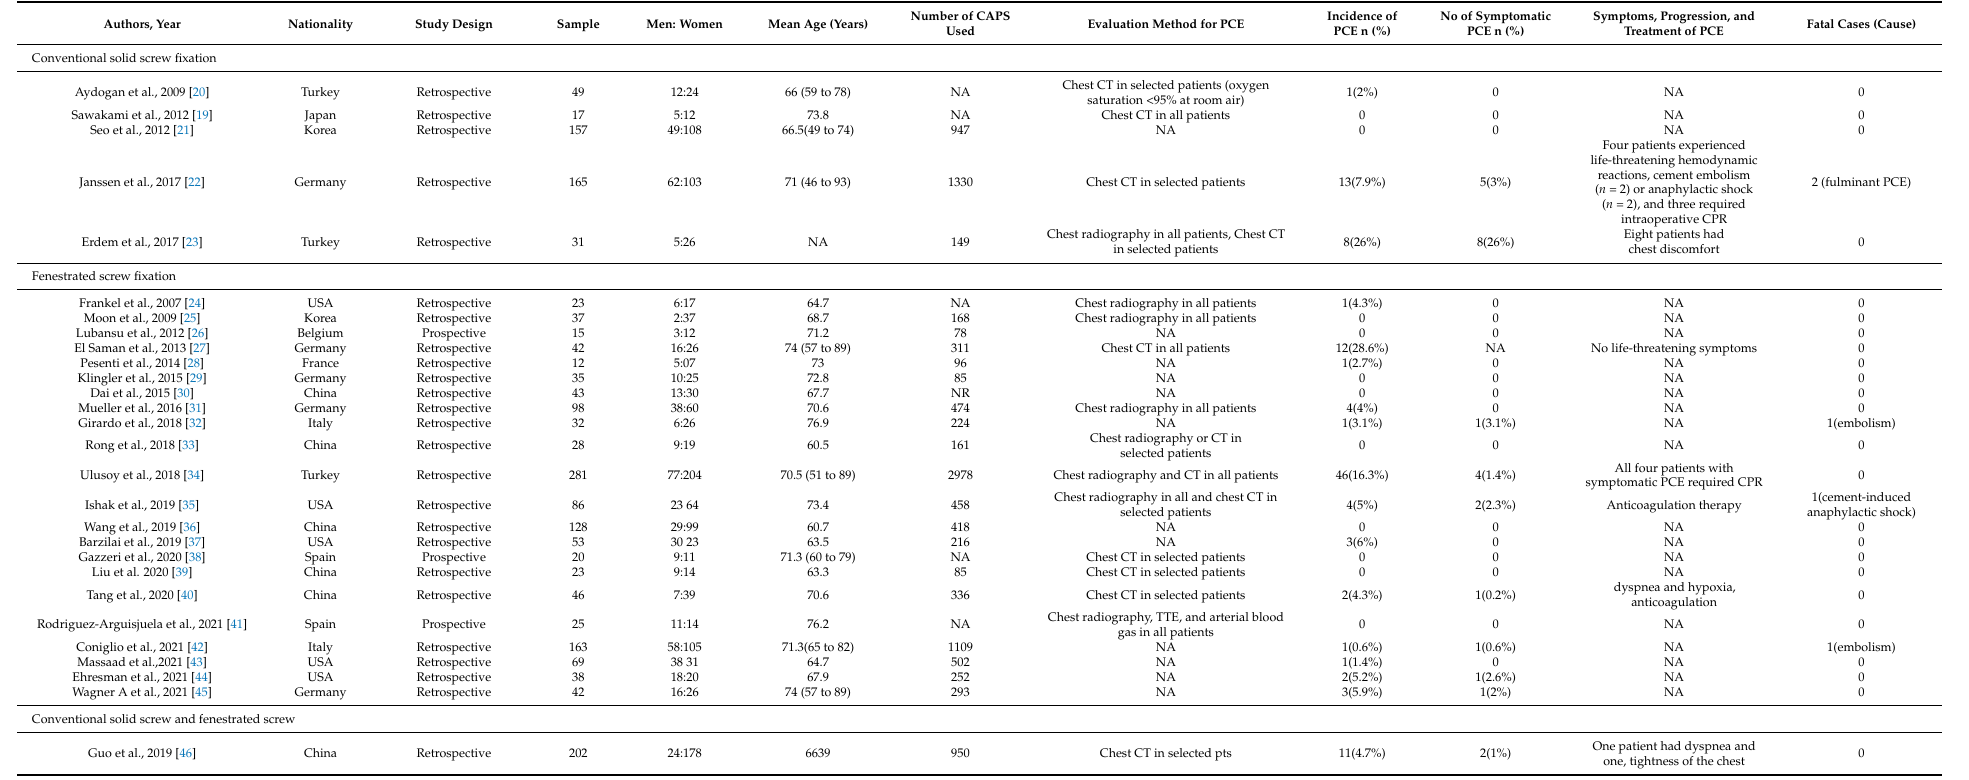
Table 1. Summary of study